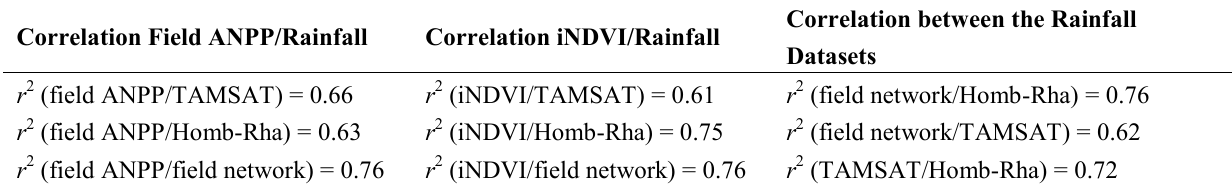
Table A1. Correlation between ANPP, iNDVI and the 3 rainfall